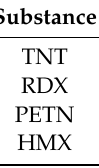
Figure 5. Amplitude of ion current in peaks of the explosives as function of volume of illuminated space inside ion source (beam volume) at different laser pulse energy: ( a ) PETN at 45 °C; ( b ) HMX at 50 °C. Table 2. Optimal intensities for ionization of explosives in vapor phase.